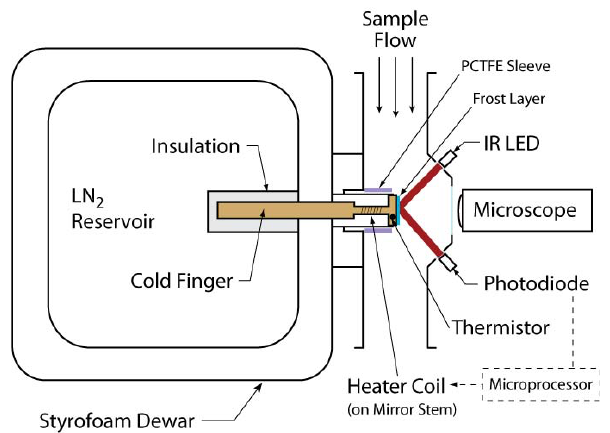
Fig. 1. Schematic of the laboratory CFH instruments used for the HNO 3 experiments. Drawing not to